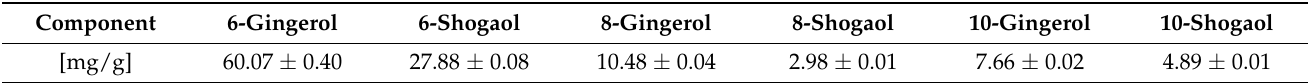
Table 2. Content of different ginger components in hemp-ginger